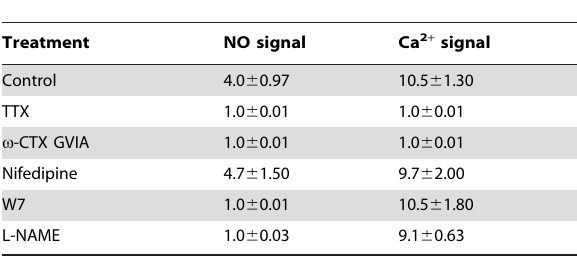
Values represent mean 6 SEM of normalized fluorescence intensity in arbitrary units after EFS from three independent experiments.